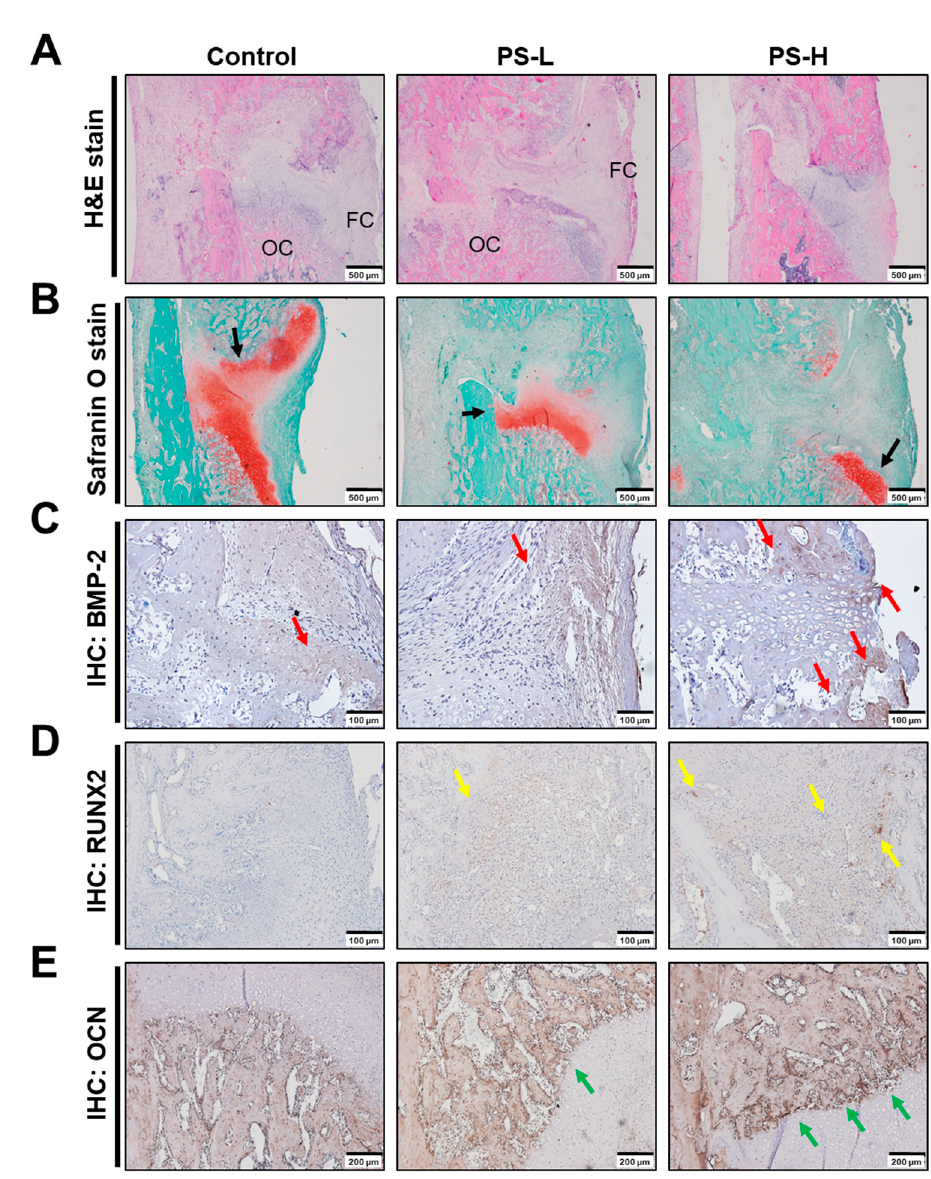
Figure 5. Morphological changes in the fractured femur veri fi ed by H&E staining and safranin O staining. ( A ) Changes in fi brous (FC) and osseous calluses (OC) veri fi ed by H&E staining (×40, scale bar 500 µm). ( B ) Cartilage areas of fracture sites (black arrow) analyzed by safranin O staining (×40, scale bar: 500 µm). IHC staining was performed to measure the expression of osteogenic factors in femoral tissues. ( C ) BMP-2-positive areas are indicated by red arrows (×200, scale bar: 100 µm). ( D ) RUNX2-positive areas are indicated by yellow arrows (×200, scale bar: 100 µm). ( E ) OCN-positive areas are indicated by green arrows (×100, scale bar: 200 µm).